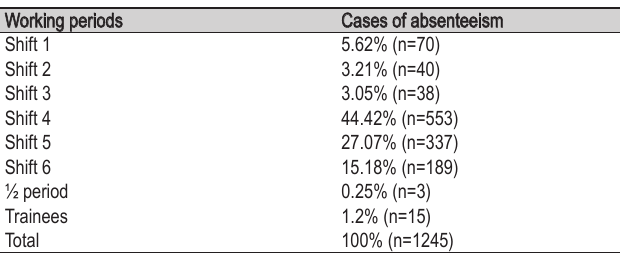
Table 3 - Distribution of absenteeism cases related with working